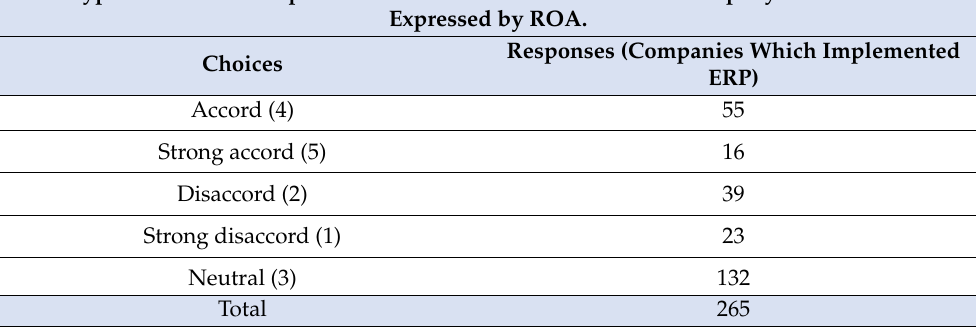
Table 4. Results of responses to questionnaire for Hypothesis 1-respondents who implemented ERP and who filled in the questionnaire.